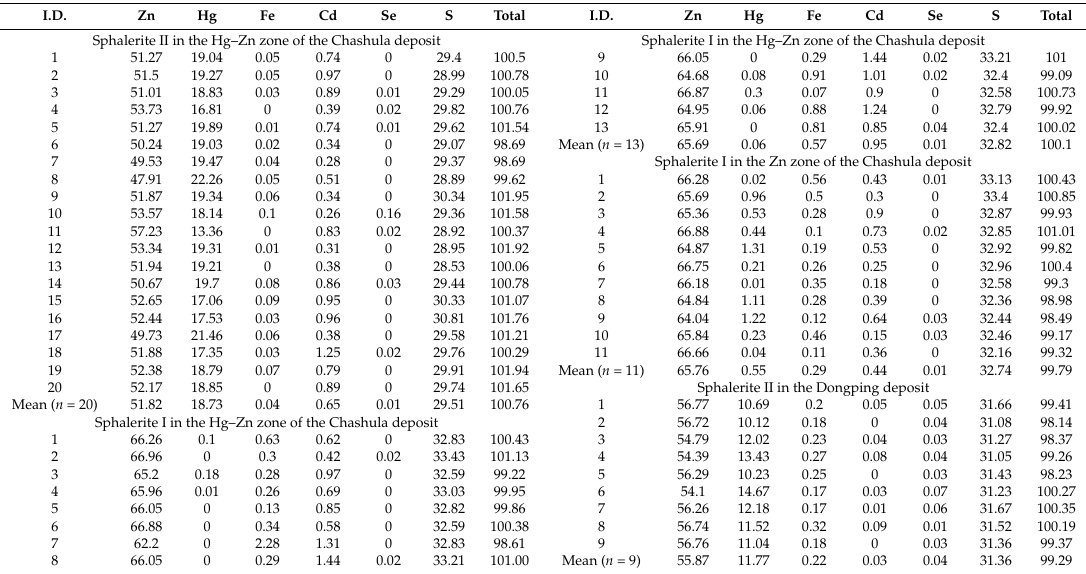
Table 1. EPMA data for sphalerite II and I from the Chashula and Dongping deposits (wt %). I.D.